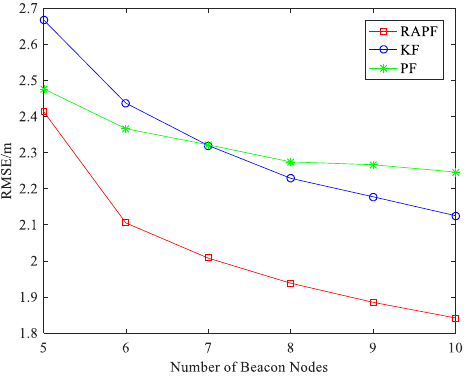
Figure 15. The RMSE versus the number of beacon nodes.